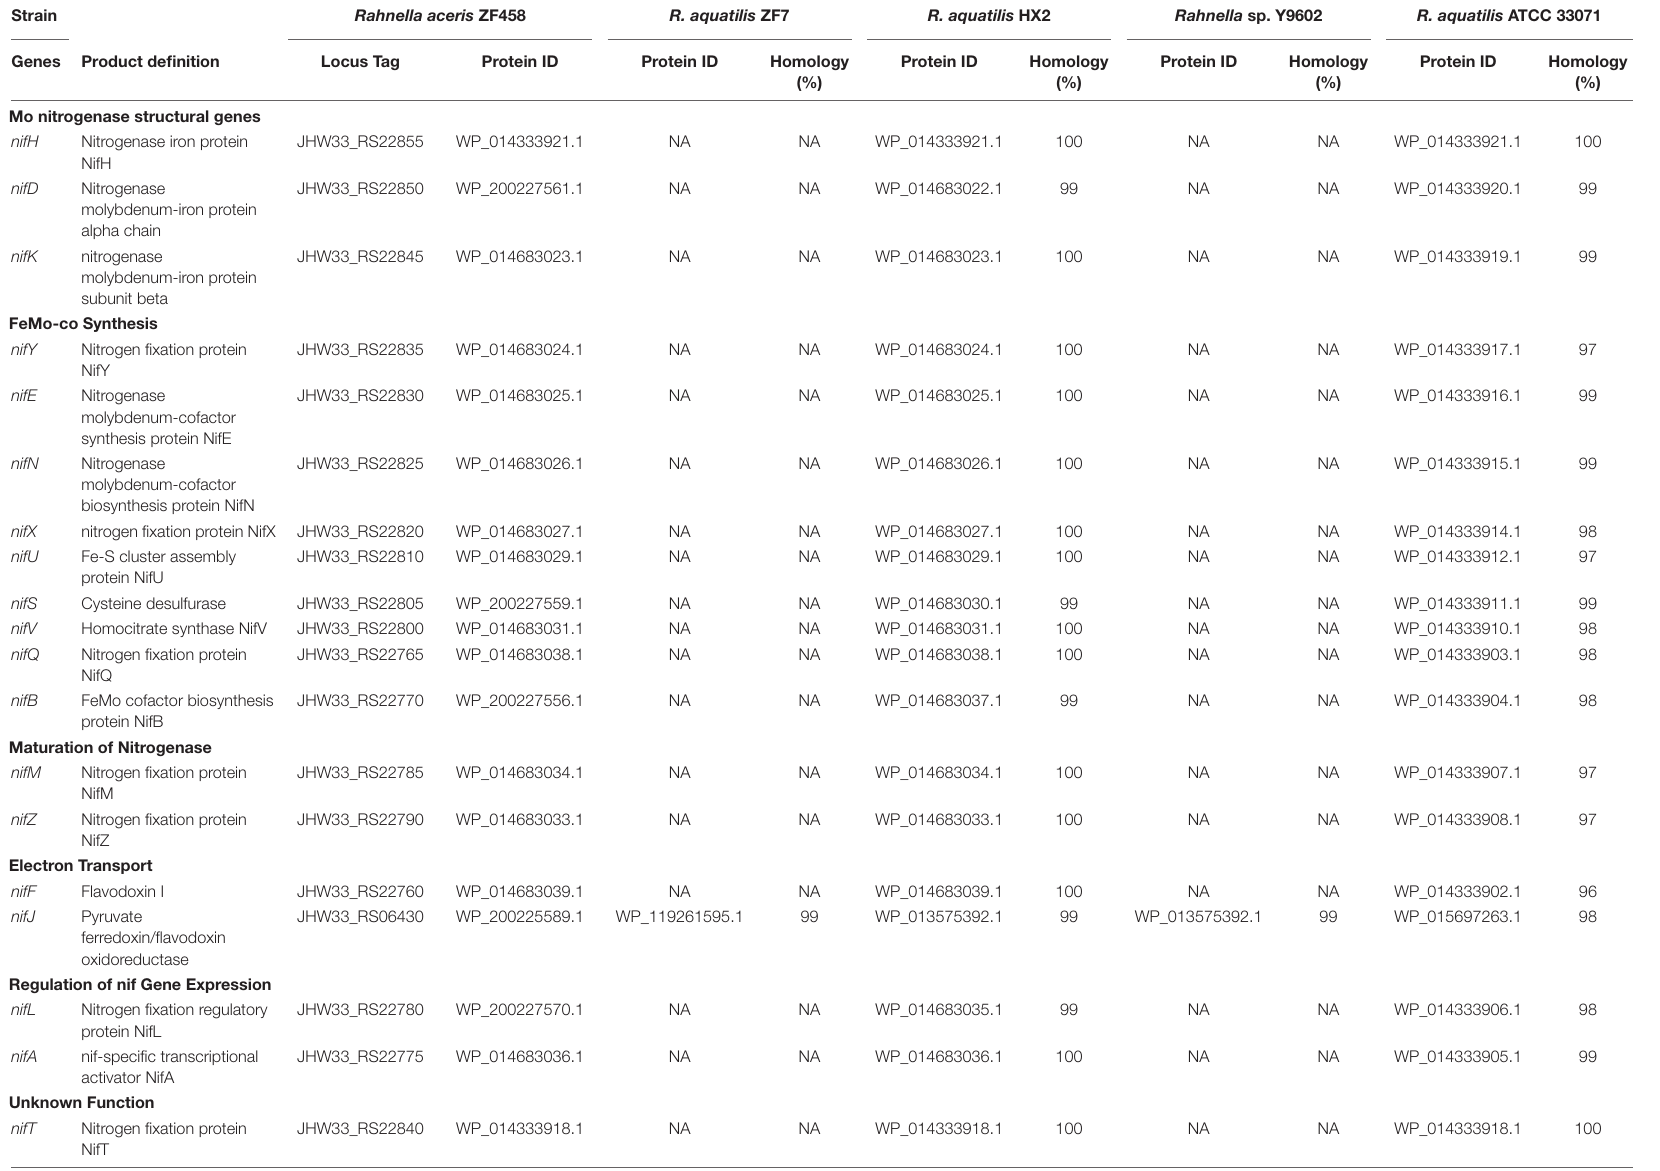
TABLE 3 | Homolog analysis of nitrogen fixing gene cluster in R. aceris ZF458 and other Rahnella strains.